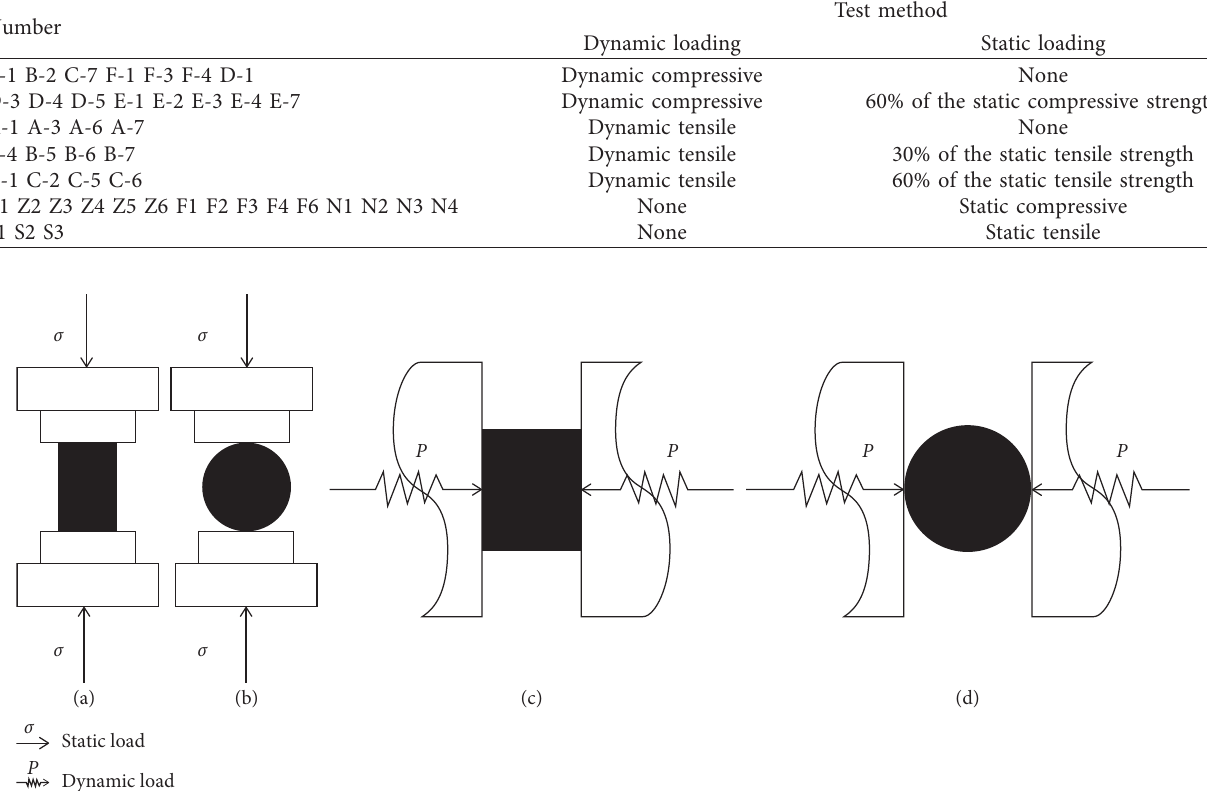
Figure 1: Schematic diagram of different loading modes (in which, (a) represents the test of uniaxial compression, (b) represents the test of Brazilian split, (c) represents the test of dynamic tensile, and (d) represents the test of dynamic